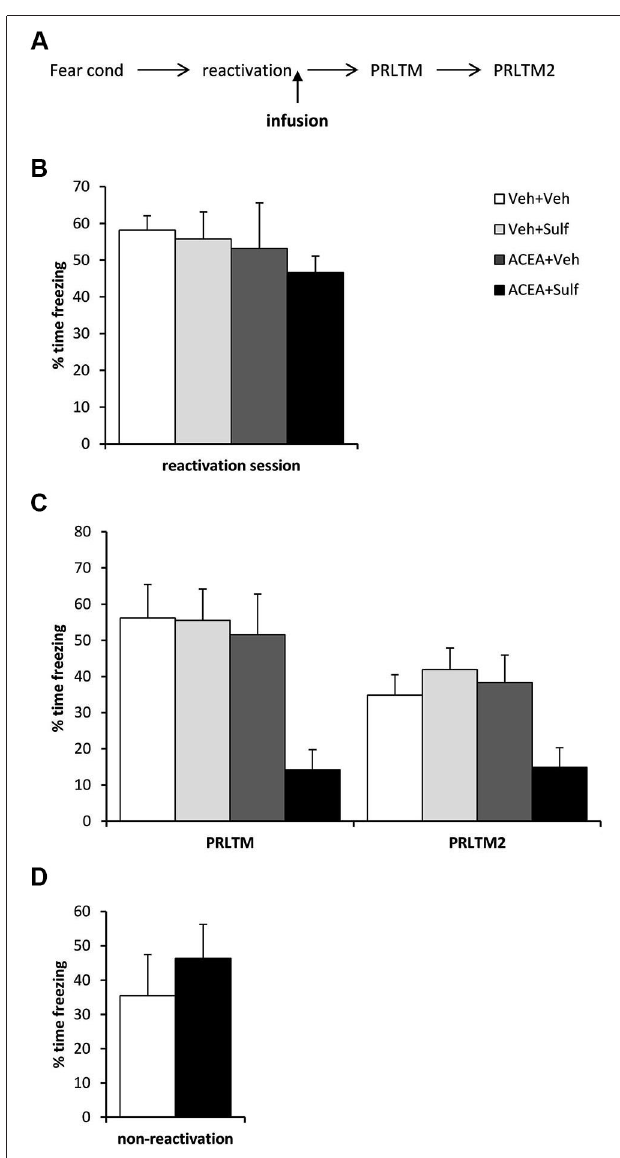
FIGURE 2 | Stimulation of memory destabilization by CB1 receptor agonism . ( A ) Schematic representation of the experimental procedure. ( B ) Prior to infusion, there were no pre-existing differences in contextual freezing at memory reactivation. ( C ) Co-infusion of ACEA and sulfasalazine (Sulf) into the dorsal hippocampus immediately after memory reactivation impaired memory reconsolidation, whereas infusion of ACEA or Sulf alone had no amnestic effect. Contextual freezing was assessed 24 h (post-reactivation long-term memory, PRLTM) and 7 days (PRLTM2) after memory reactivation. ( D ) Co-infusion of ACEA and Sulf in the absence of memory reactivation did not affect subsequent contextual freezing. Data presented as mean + s.e.m. ( N = 6–7 per